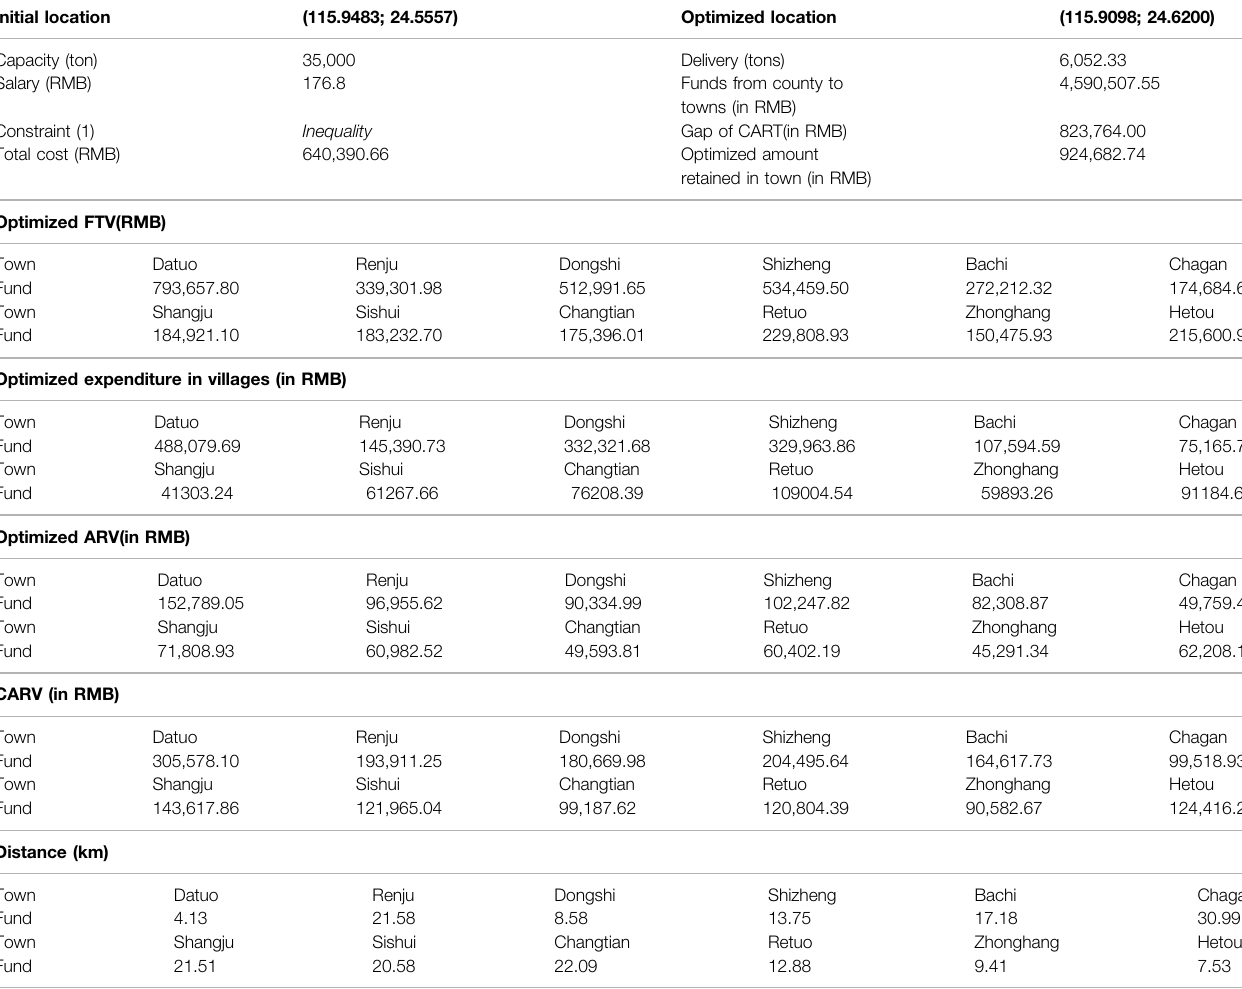
TABLE 1 | Optimization results given inequality (3) and capacity ≤ 35,000 tons for constraint